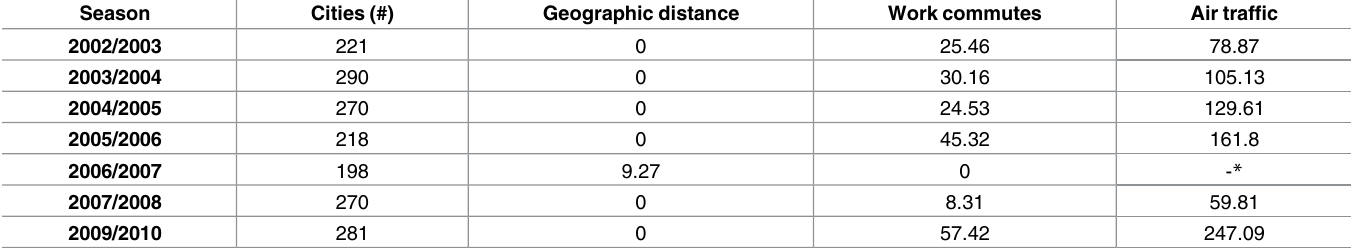
Table 2. Change in AIC values for the spatial models using geographic distance, work commutes and domestic air traffic as the links between locations driving inter-city spread, compared to the model with the minimum AIC in each season. The numberof cities available for analysisis based on the subset of 310 cities for which onset time could be estimated and which could be successfully matched with county-level commute data from the census. Spatial models were not fit to the 2008/2009 epidemicbecauseof lack of detectableinfluenzaonset times in a sufficient numberof locations.